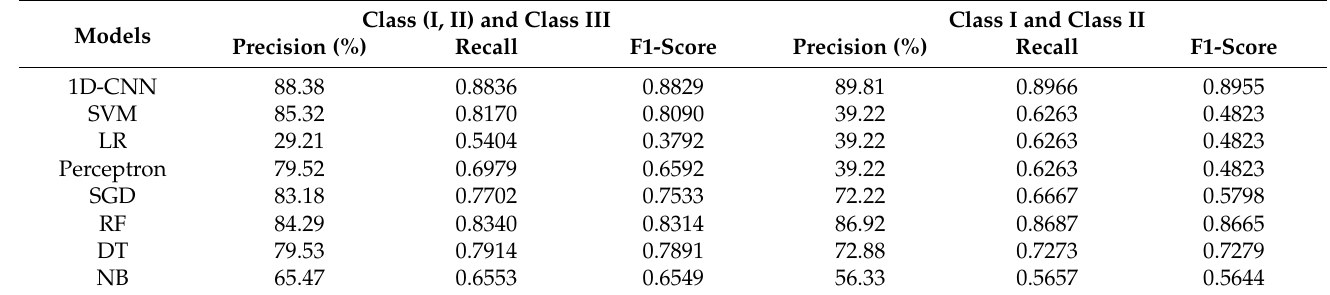
Table 5. Precision, Recall, and F1-score of the classification based on different machine learning models.